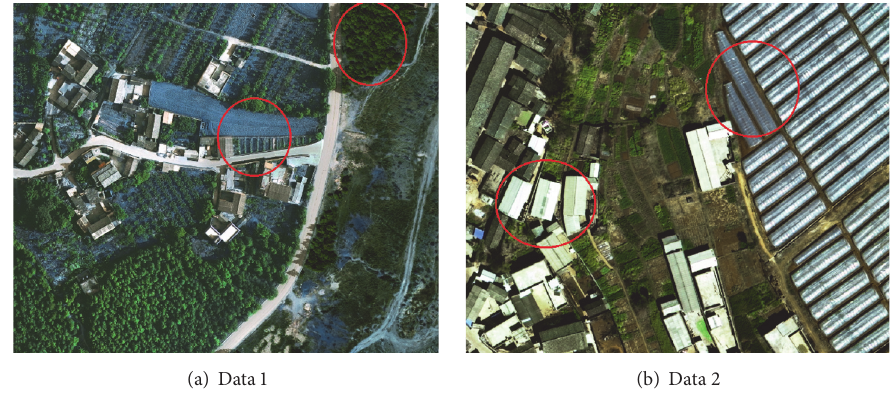
Figure 3: Image of Anning